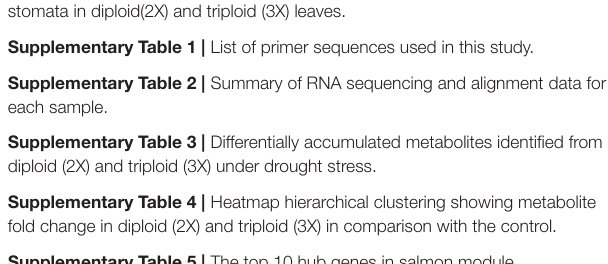
Supplementary Table 5 | The top 10 hub genes in salmon